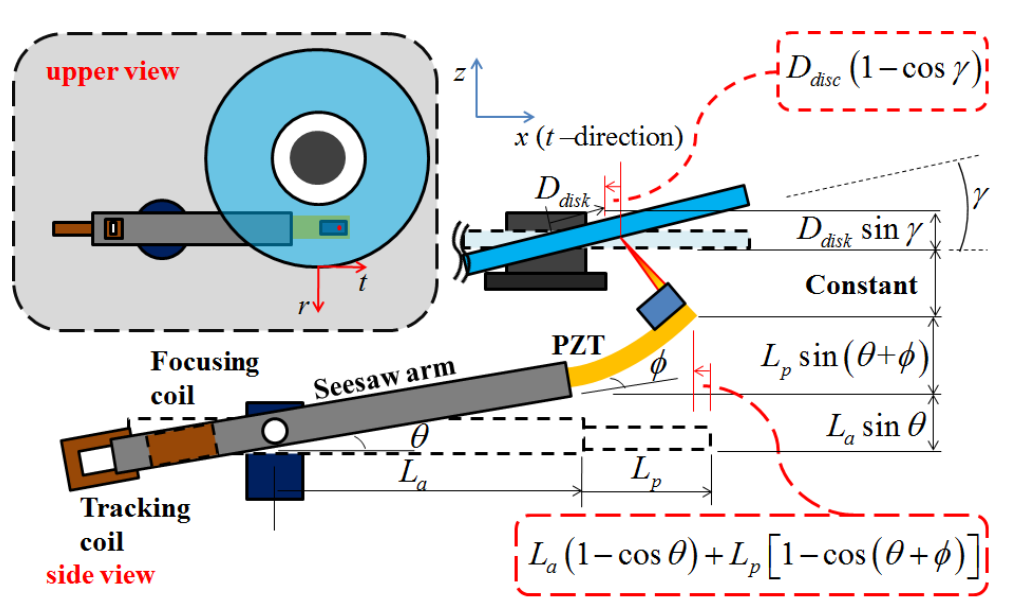
Figure 6. Geometry and coordinates for the dual stage actuator based on electromagnetism and mechanism ( t and r present tangential and radius direction respected to the disk).